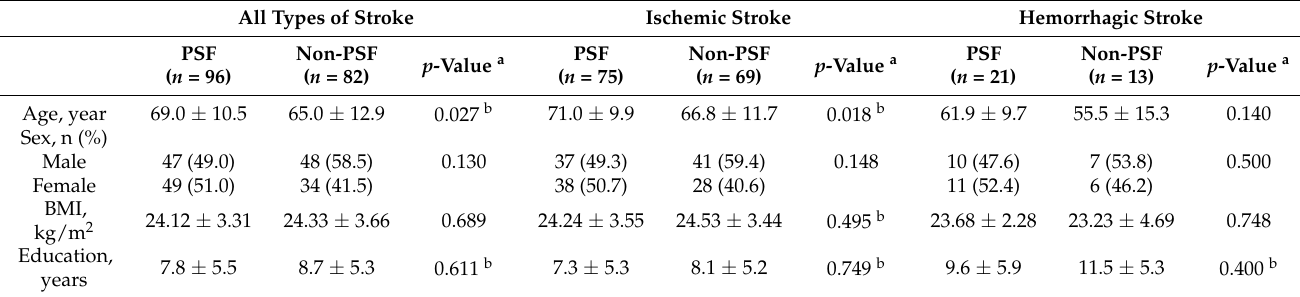
Table 1. Comparison of demographic characteristics between the PSF and non-PSF